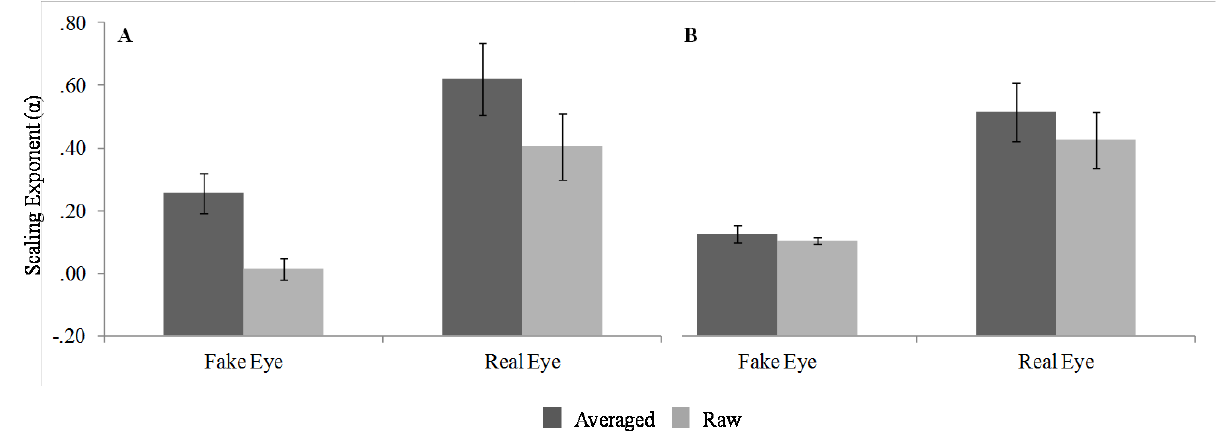
Figure 3. The effects of eye type and data-averaging in (a) PSD analysis and in (b) DFA. Multifractal Analyses